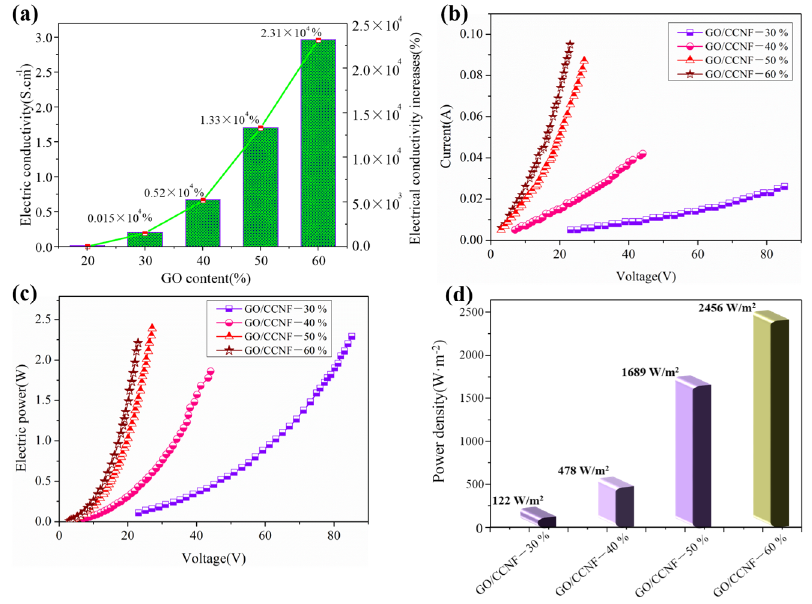
Figure 4. Electrical properties of GO/CCNF films. ( a ) conductivity; ( b ) voltage–current curves; ( c ) power–voltage curves; ( d ) power density.